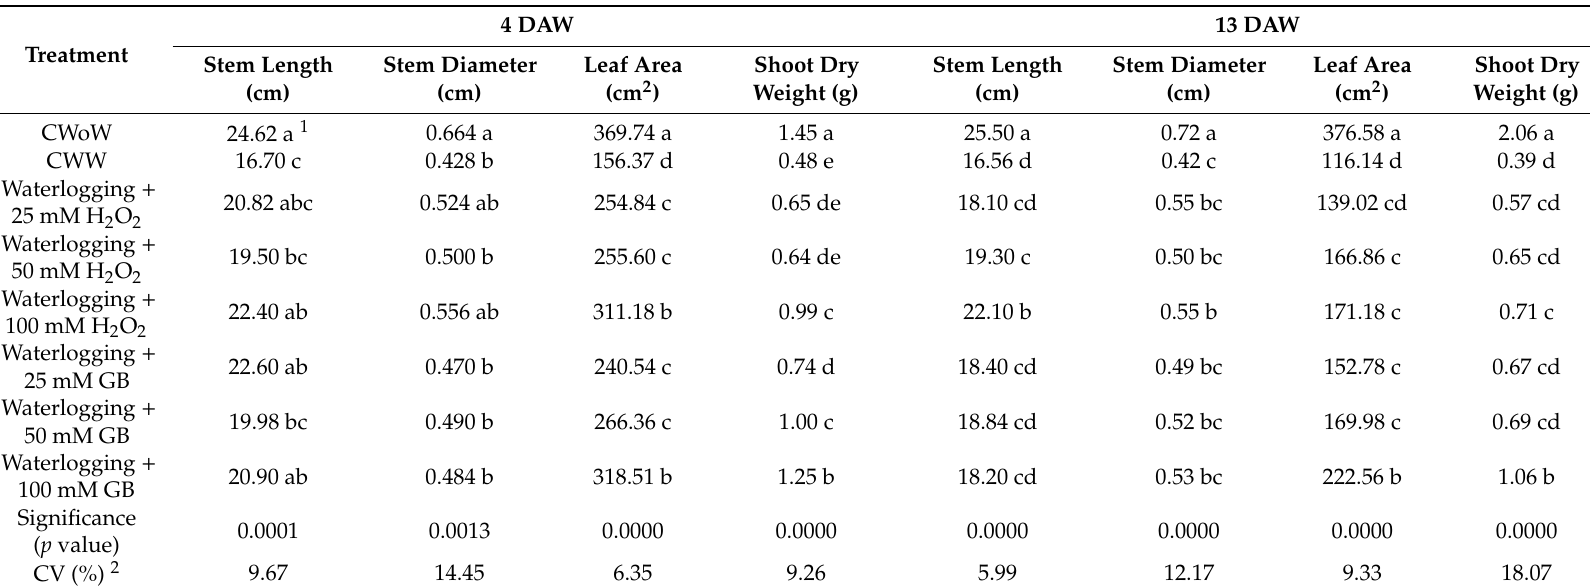
Table 1. Stem length, stem diameter, leaf area, and shoot dry weight of Cape gooseberry ( Physalis peruviana L.) plants ecotype Colombia subjected to a waterlogging period and with exogenous applications of 25, 50, and 100 mM of hydrogen peroxide (H 2 O 2 ) or glycine betaine (GB), respectively. Control without waterlogging (CWoW) and control with waterlogging (CWW). Evaluated at 4 and 13 days after waterlogging